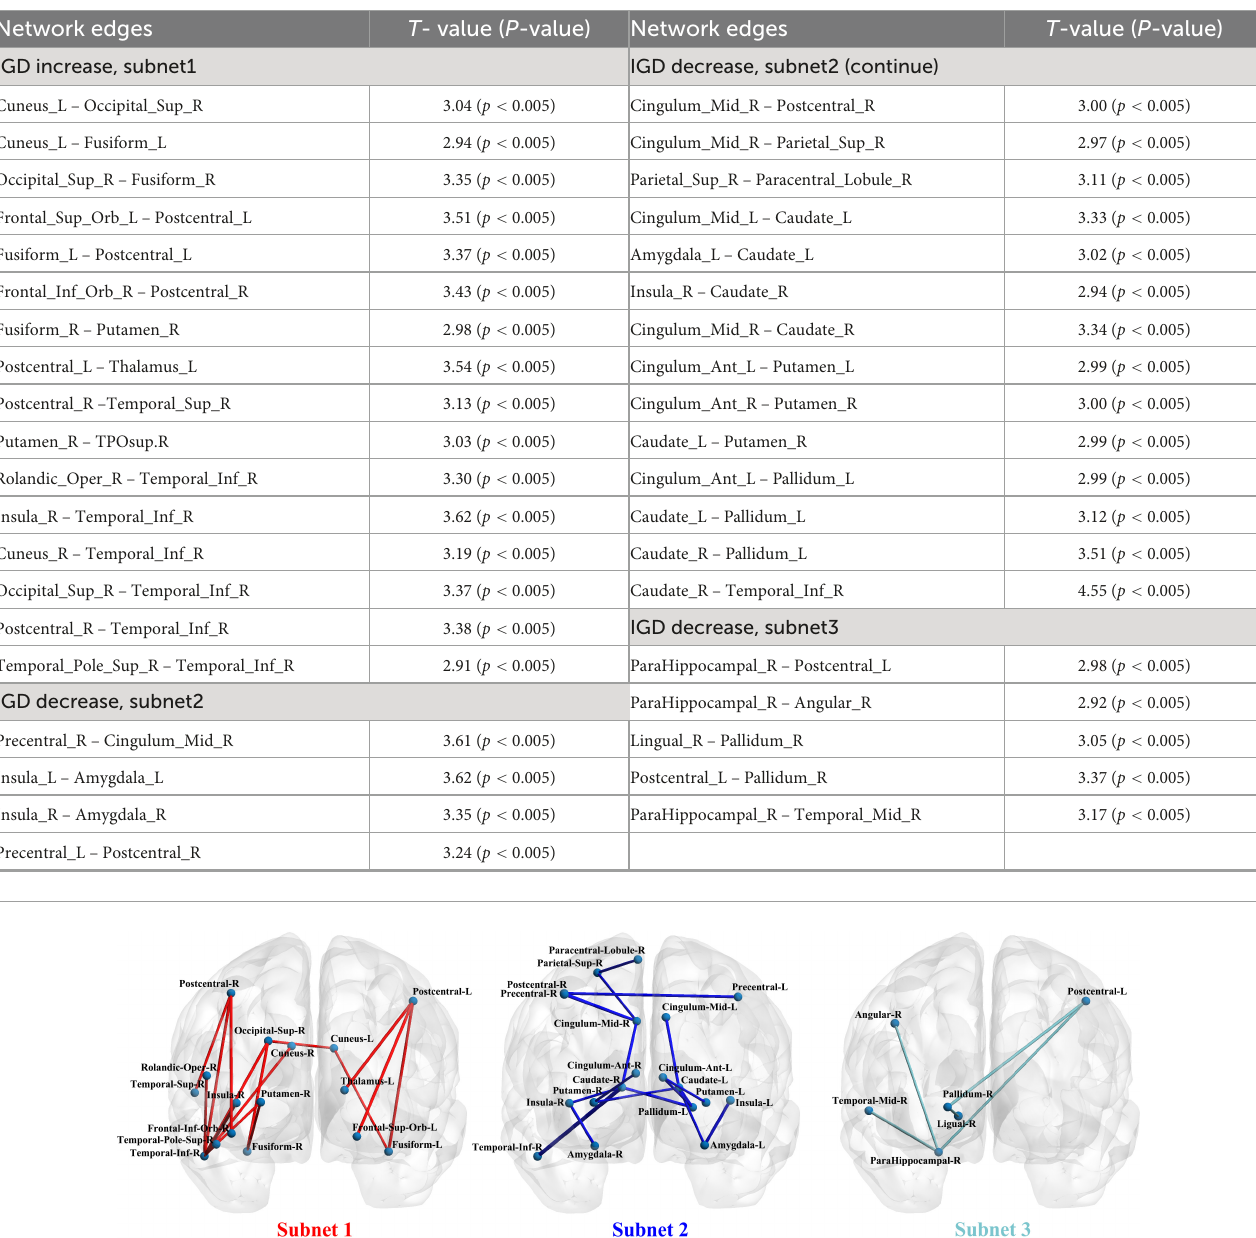
TABLE 2 Subnetwork with a significant between-group difference based on the network-based statistics (NBS) analysis. Network edges